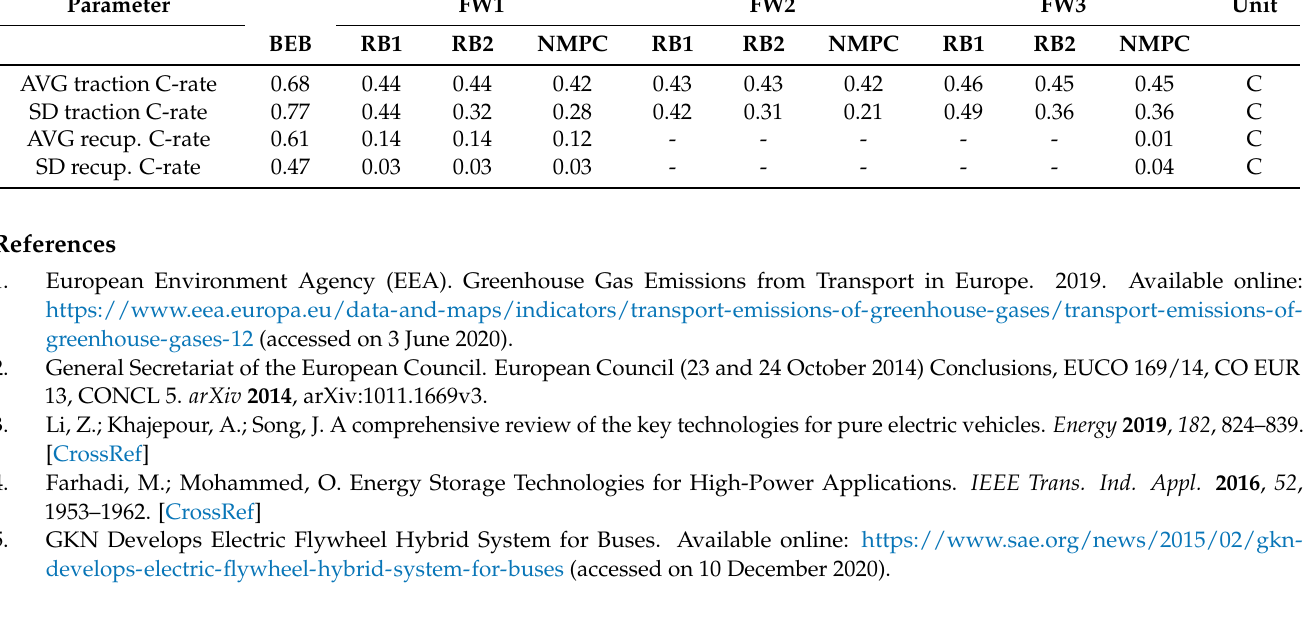
Table A2. Average and standard deviation of the battery C-rate along the BR driving cycle.